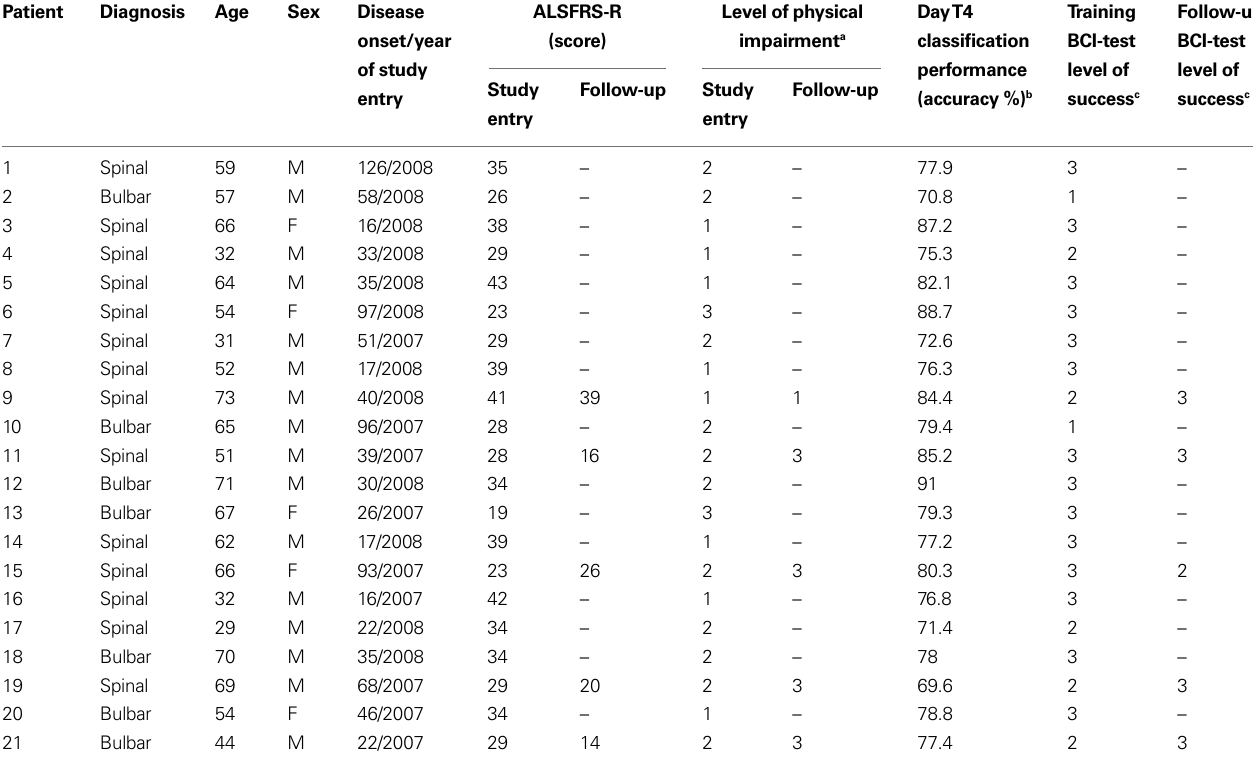
Table 2 | ALS patients demographic and clinical